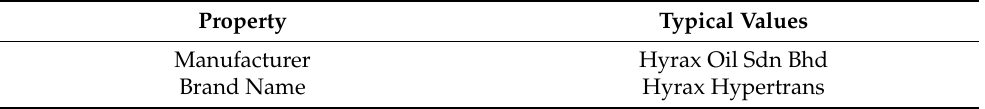
Table 1. Specifications of mineral oil used.